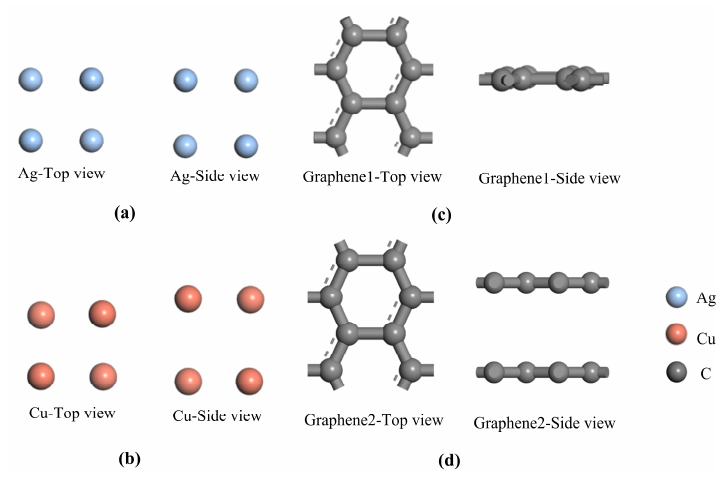
Figure 1. Optimized traditional metal electrode plate models and graphene models: ( a ) traditional silver electrode plate; ( b ) traditional copper electrode plate; ( c ) single-layer graphene; ( d ) double- layer graphene.